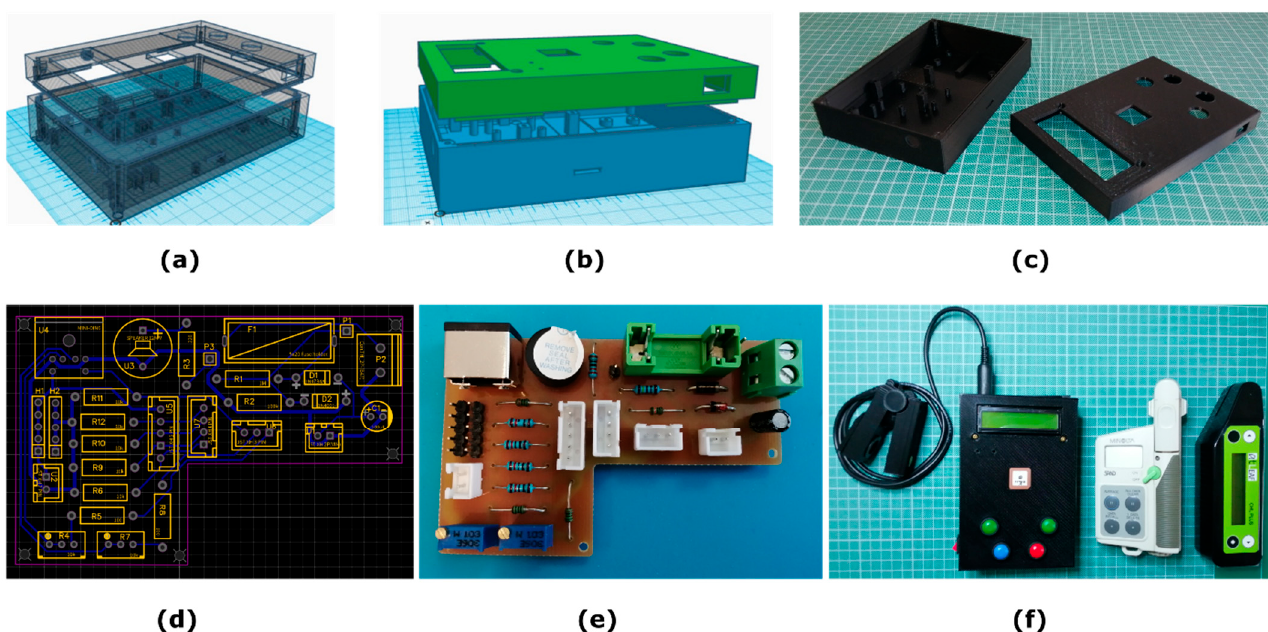
Figure 4. The designed model’s front (dimensions-WxLxH: 100 mm × 149.18 mm × 17 mm) and back cover (dimensions-WxLxH: 100 mm × 149.18 mm × 29.02 mm) of the “control box” are shown in ( a ) and ( b ), along with the 3D-printed parts ( c ). The designed ( d ) and constructed ( e ) simple, one-sided, auxiliary PCB is shown. In ( f ), the experimental meter is shown along with the two commercial chlorophyll meters, the SPAD-502 and atLeaf CHL Plus.